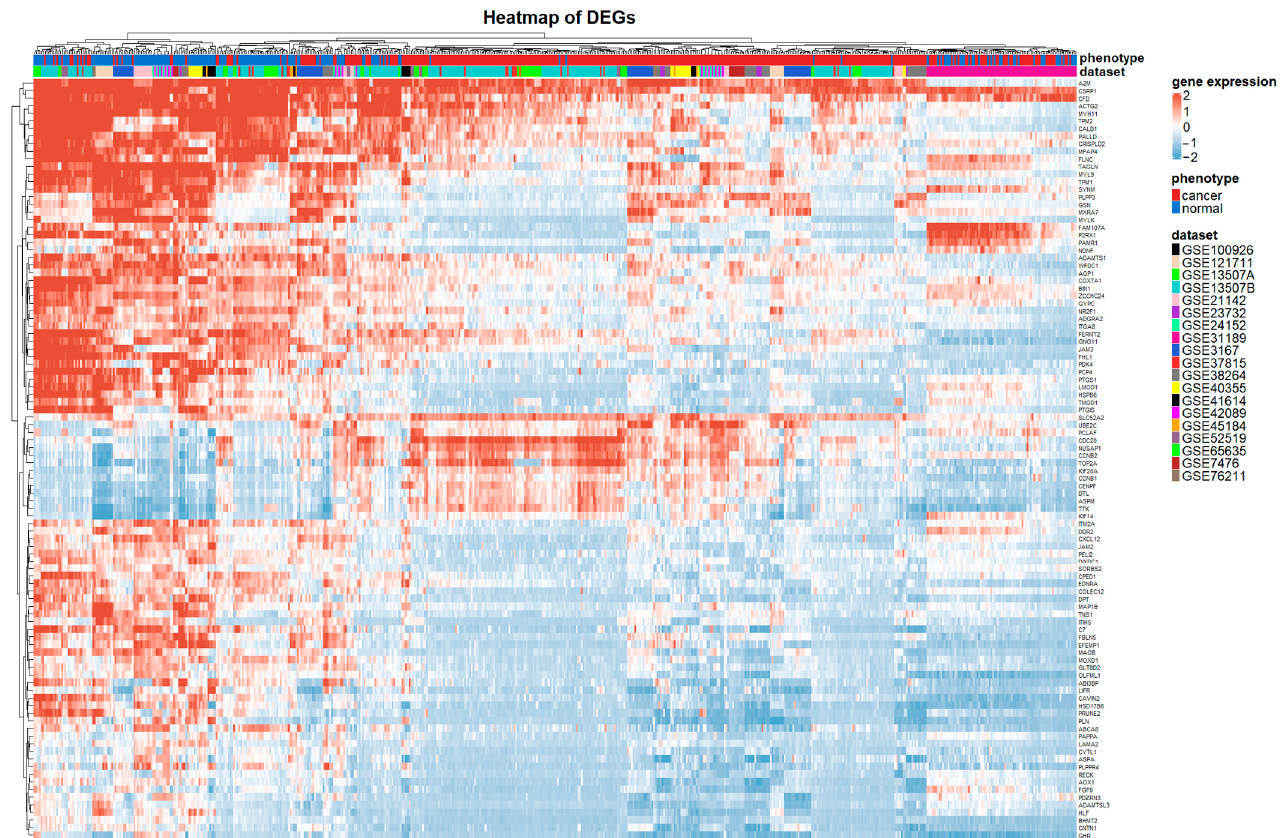
Figure 3. Heatmap plot of the top 100 DEGs between BCa and control samples in the merged meta- dataset. Blue and red represent relative downregulation and upregulation, and white represents no significant change in gene expression. Horizontal and vertical axes are clustered by genes and samples, respectively.